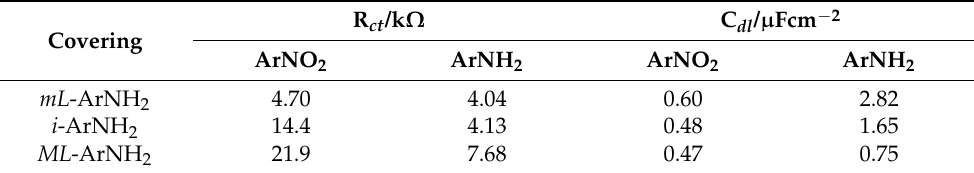
Table 2. Circuit parameters 1 from impedance data (average solution resistance: 48.5 Ω ).